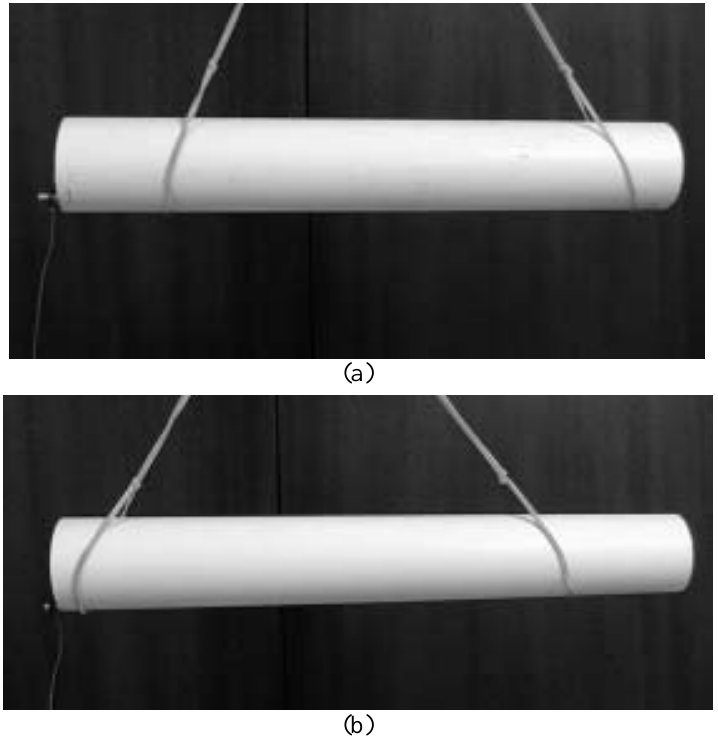
Fig. 10. Experiment: (a) uniform PVC shell, (b) tapered PVC